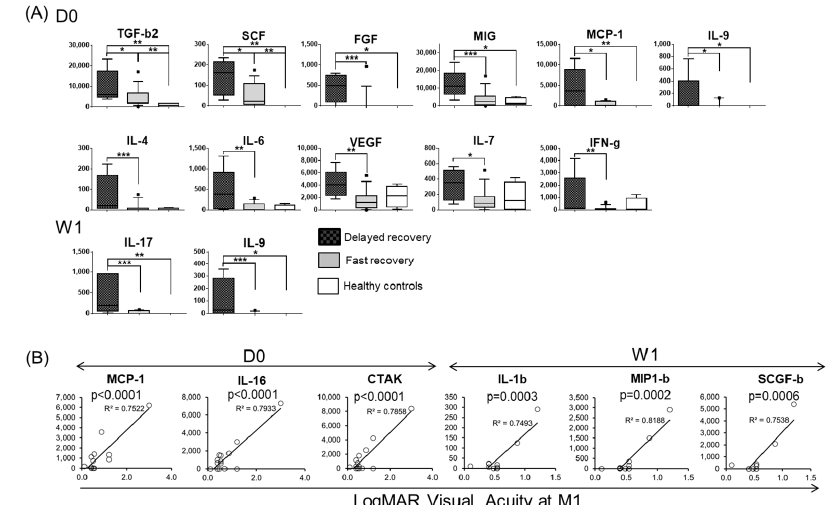
Figure 6. Tear protein expression at Day 0 and Week 1 associated with recovery after EK. ( A ) The expression levels of proteins significantly associated with rapid recovery of corneal haze, measured one month post-transplant, are shown. The delayed recovery group (Corneal haze + at Month 1 (M1); n = 5), and the fast recovery group (non-corneal haze at M1; n = 15), age-matched controls: n = 4. Data are shown in pg / mL. The median, 10%, 25%, 75, 90% percentiles are shown. * p < 0.05, ** p < 0.02, *** p < 0.01. ( B ) The correlation between tear protein expression and LogMAR visual acuity measured one month post-transplant. Proteins significantly associated with visual acuity are shown. n =